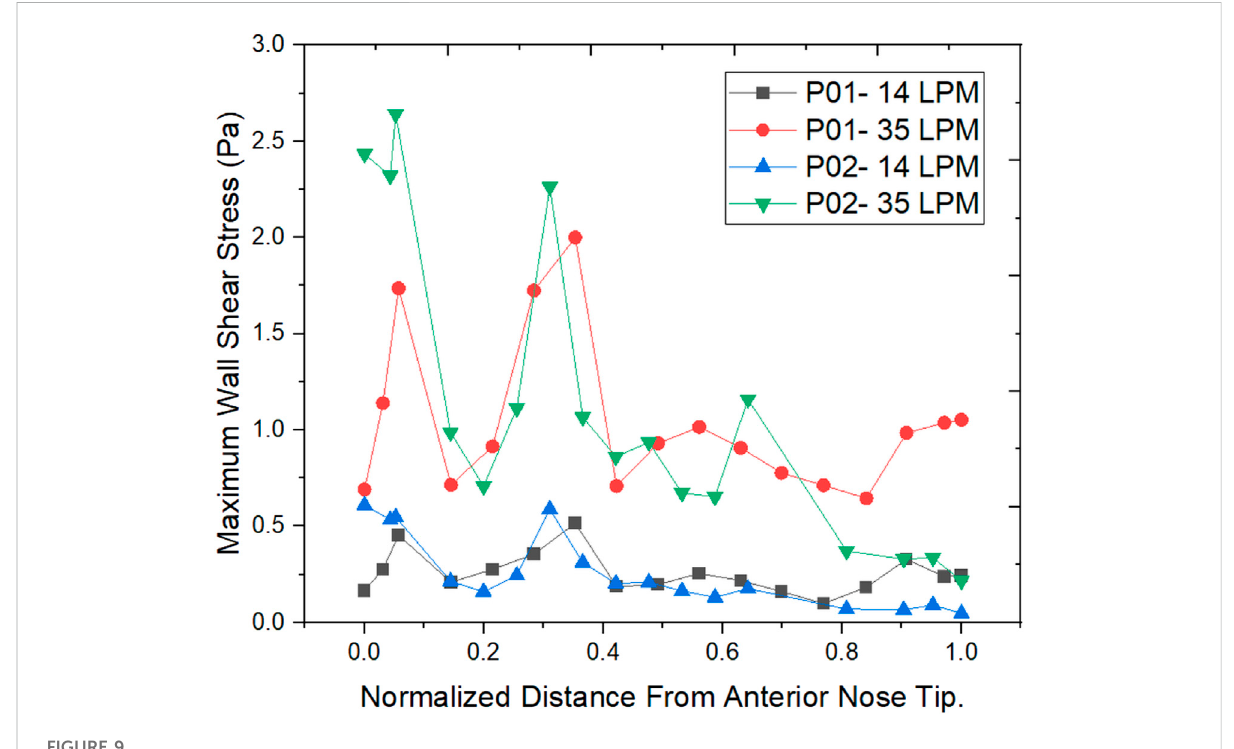
FIGURE 9 Wall shear stress comparision along length at different